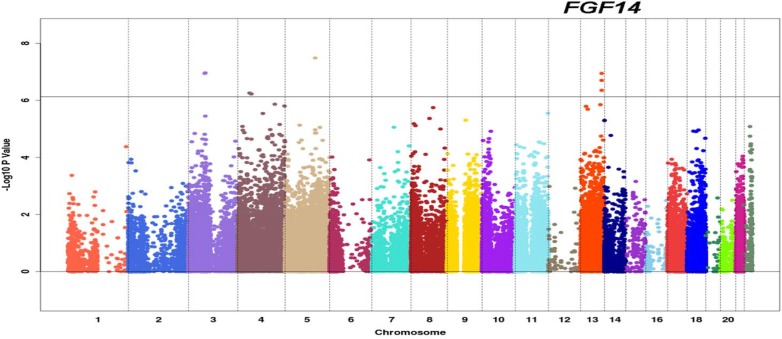
Manhattan plot of p-values for testing interaction effects between each probe’s LOH status and its DNA copy number in Cox regression models for OSCC-specific survival.The X-axis shows the genome order with different chromosomes separated by vertical dashed grey lines. The Y-axis shows the negative log10 p-values from log-likelihood ratio test for testing the interaction term (CNV*LOH) in the Cox model that included terms for sex, age, and smoking history. The horizontal grey line corresponds to Bonferroni cutoff 0.05/66875.